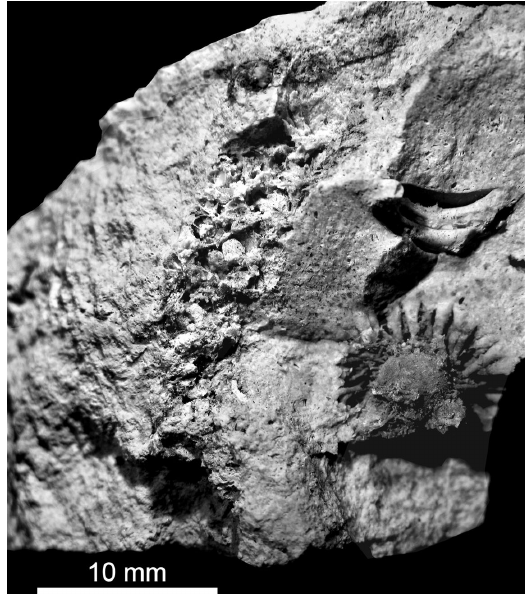
Fig. 8. Fragment of a type 2A boulder showing a tube-like infill. Right: Coelosphaeridium sphaericum. RGM 1317645, Wilsum.